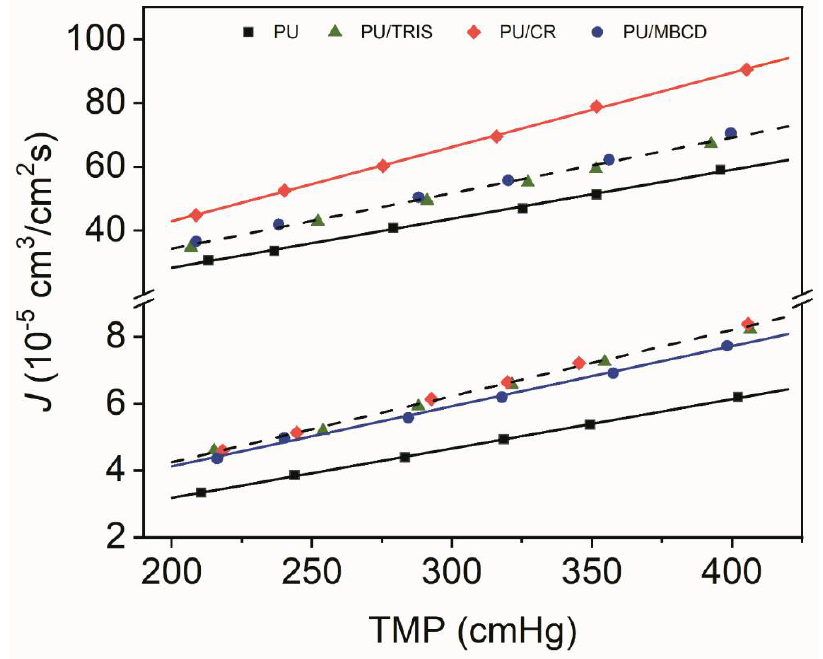
Figure 8. O 2 (lower group of points—below 20 × 10 −5 cm 3 /cm 2 s) and CO 2 (higher group of points— above 20 × 10 −5 cm 3 /cm 2 s) volumetric fluxes ( J ) vs. the transmembrane pressure (TMP) for the PU (black square), PU/TRIS (green triangle), PU/MBCD (blue circle), and PU/CR (red diamond) membranes. Lines (straight-line fit using the method of least squares) for CO 2 permeation flux vs. TMP: PU membrane—solid black line, PU/CR—solid red line and PU/TRIS and PU/MBCD membrane in dashed black line. For O 2 permeation flux vs. TMP: PU membrane—solid black line, PU/MBCD—solid blue line, and PU/TRIS and PU/CR membranes in dashed black. Table 3. CO 2 and O 2 permeances and permeability coefficient (P) for the non-porous symmetric membranes PU, PU/TRIS, PU/MBCD and PU/CR membranes.